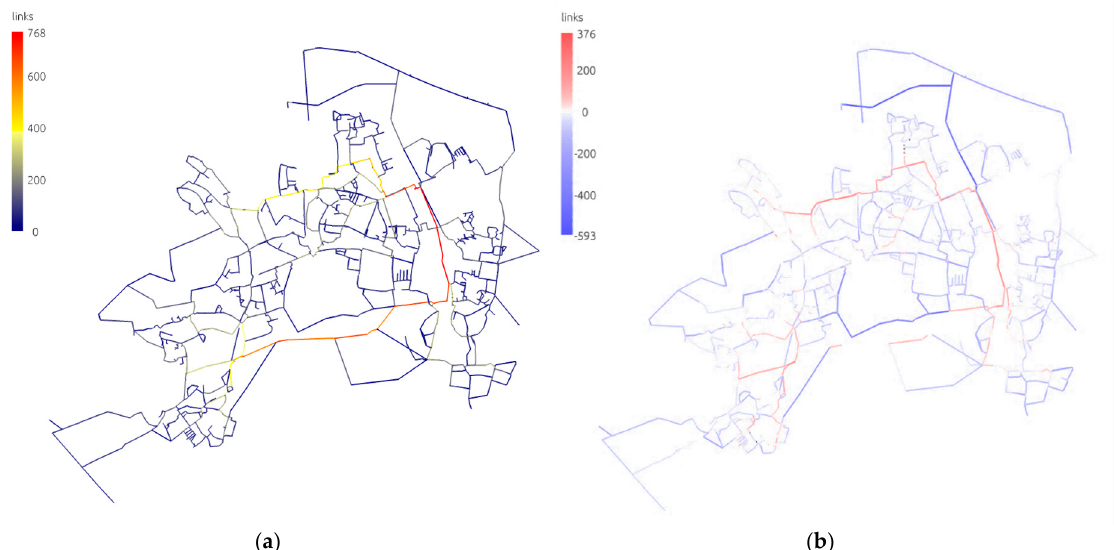
Figure 2. ( a ) Pipe diameters for the optimized network blueprint of Helmond-Mierlo. The color scale indicates the diameter values in mm. ( b ) Difference in pipe diameters between the current infrastructure and the network blueprint. The color scale indicates a decrease in diameters (blue) or increase (red). The darker the color, the larger the difference.